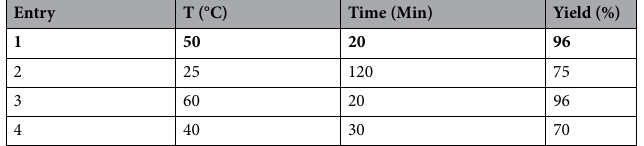
Table 6. Variation of temperature. Reaction conditions: 4-methylbromobenzene (1.0 mmol), phenylboronic acid (1.0 mmol), UiO-66-biguanidine/Pd (0.1 mol% Pd), K 2 CO 3 as base (2 mmol), EtOH/H 2 O (1:1) as solvent (3 mL); Isolated yield.